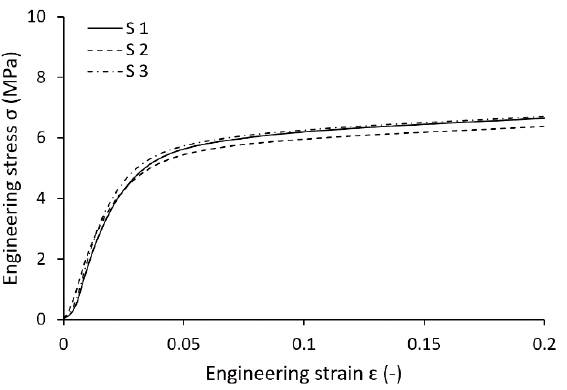
Figure 13. Compression test of BCC lattice cubes with nominal strut diameter 0.6 mm.